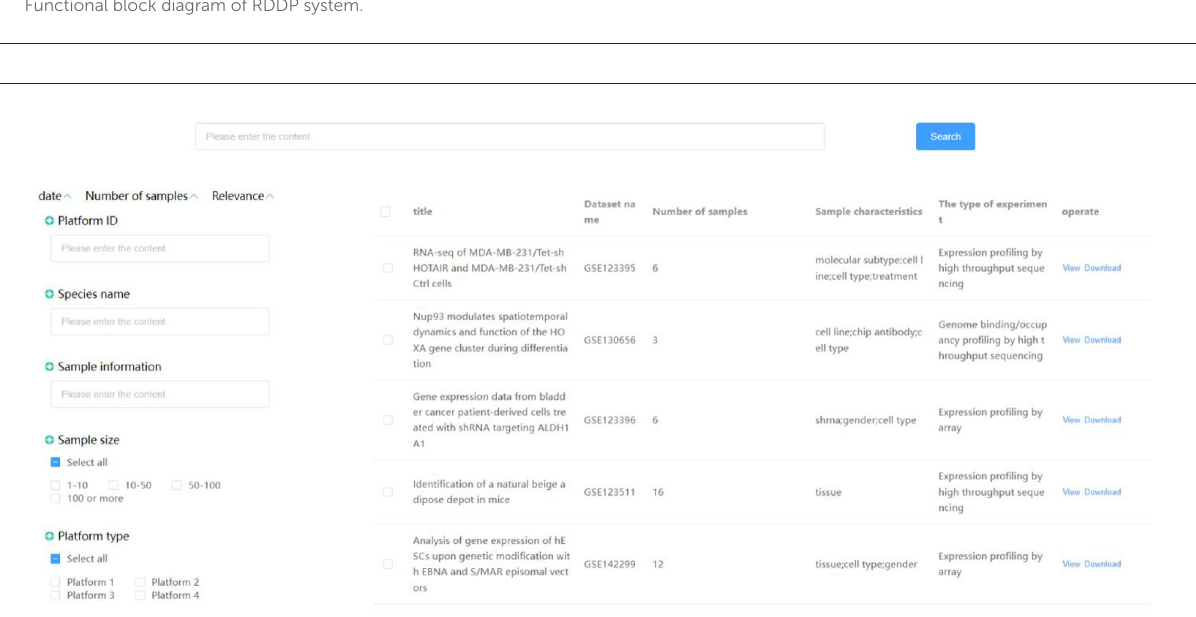
FIGURE4 Clinical data center